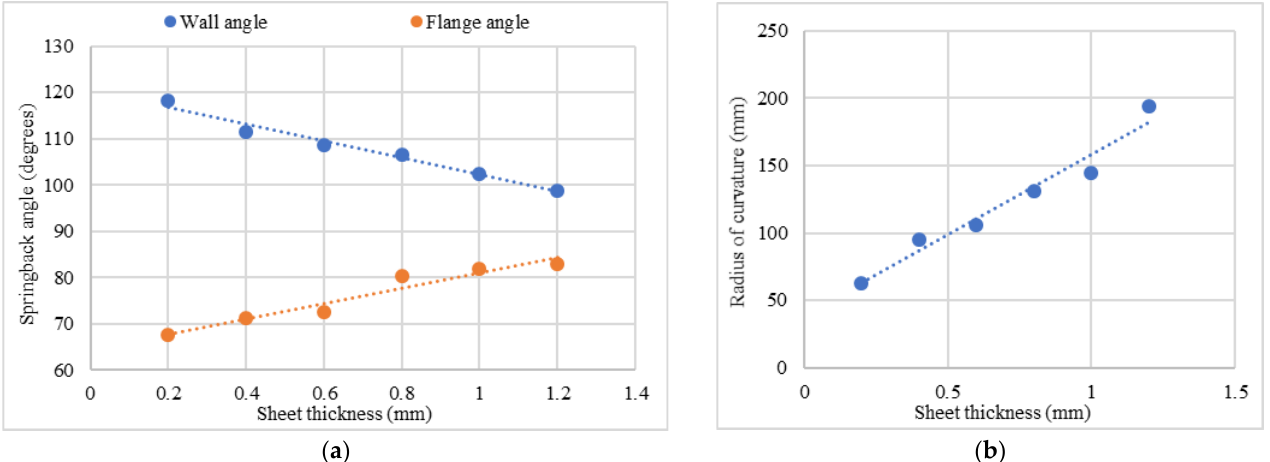
Figure 3. ( a ) Effect of sheet thickness on the springback angles of SA5182 and ( b ) Variation of radius of curvature of the wall with sheet thickness for SA5182.